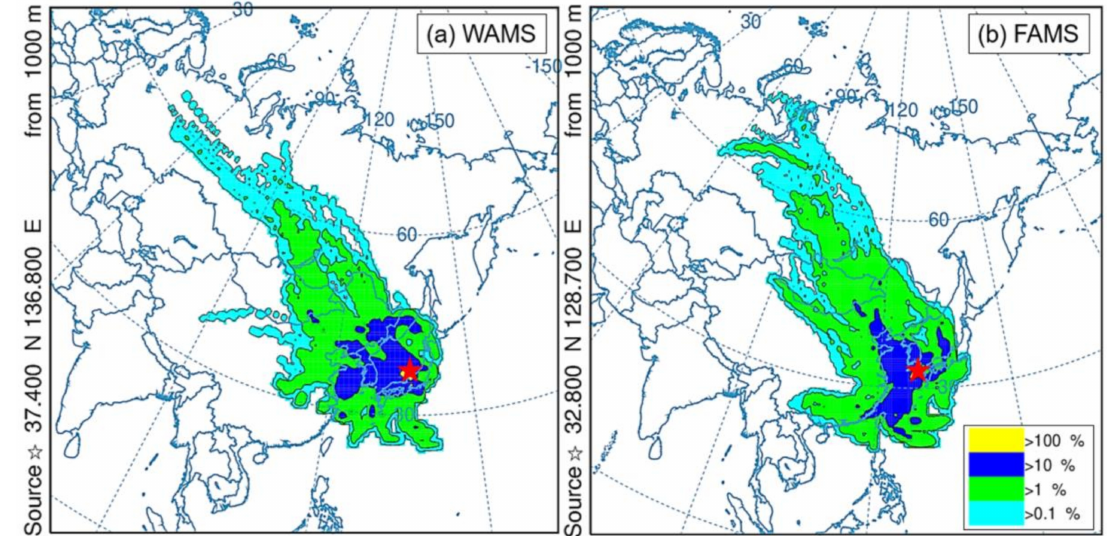
Figure 5. Frequency analysis of backward trajectories at WAMS ( a ) and FAMS ( b ) in the East Asian winter monsoon period (Period 1, 10–20 April 2017). ( (cid:70) ) sampling sites at WAMS and